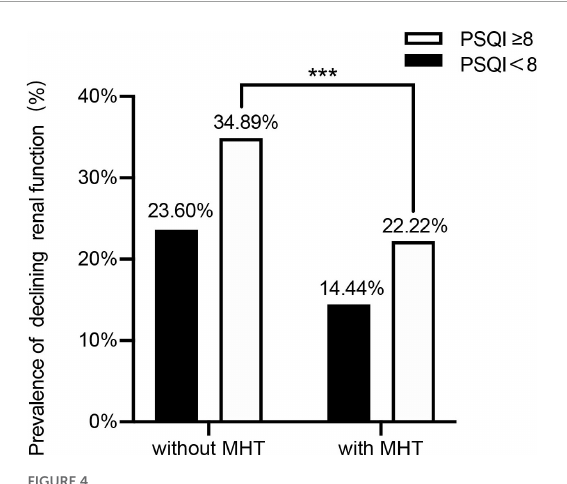
FIGURE4 Sleep disorder and MHT on the prevalence of declining renal function. *** p <